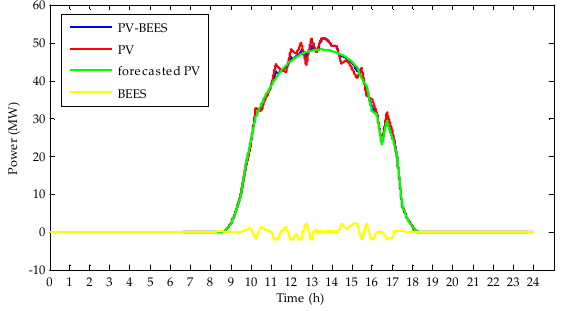
Figure 8. The PV power curve optimized by the BESS.